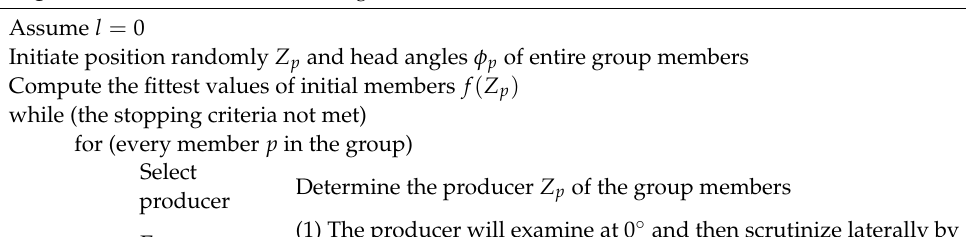
Algorithm 2: Conventional GSO